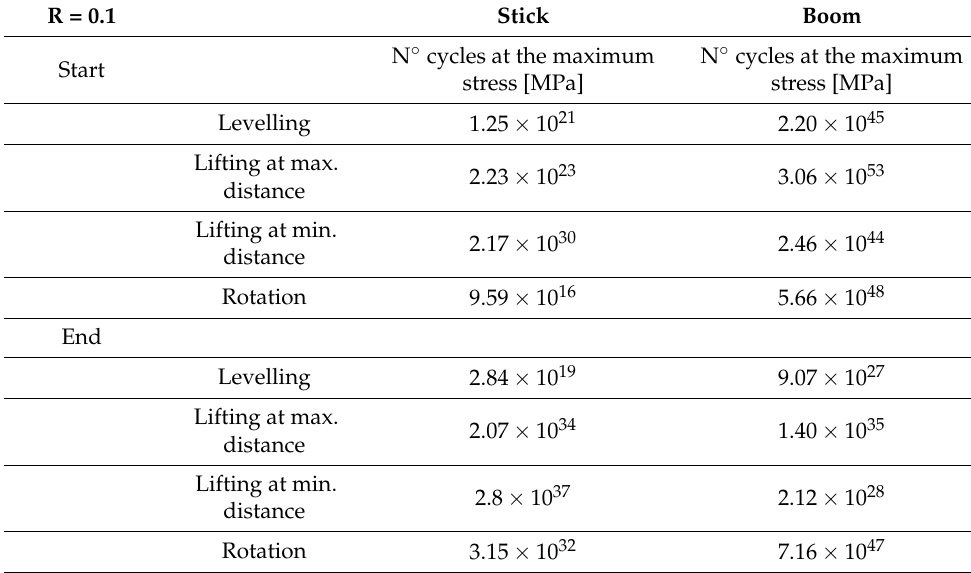
Table 10. Number of cycles at the maximum stress for R = 0.1. R =